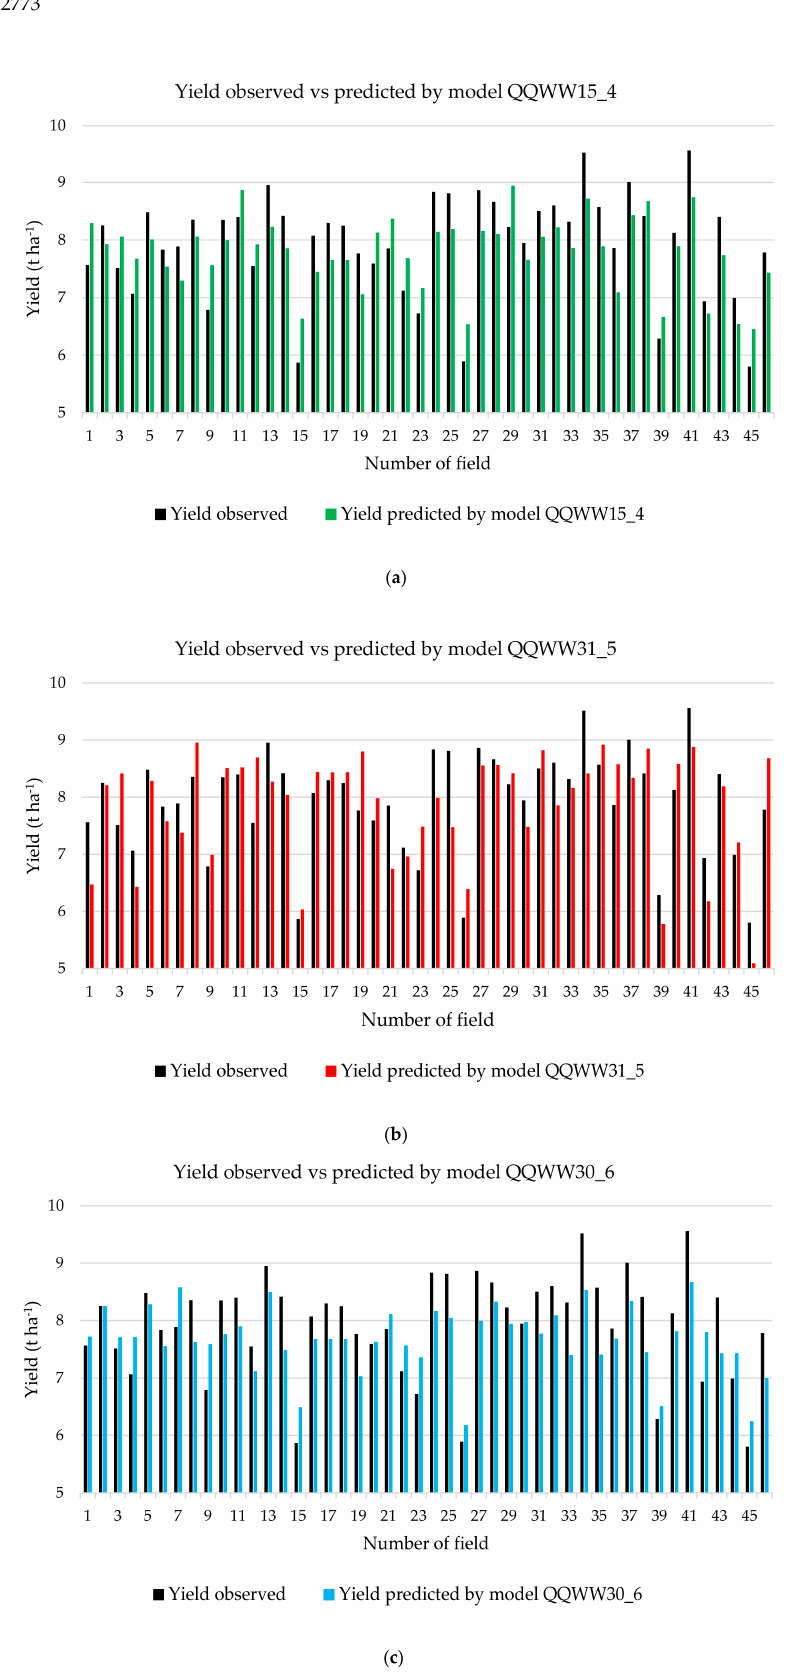
Figure 3. Graphical presentation of observed and predicted yield by neural model: ( a ) QQWW15_4, ( b ) QQWW31_5, and ( c ) QQWW30_6. Network Sensitivity Analysis